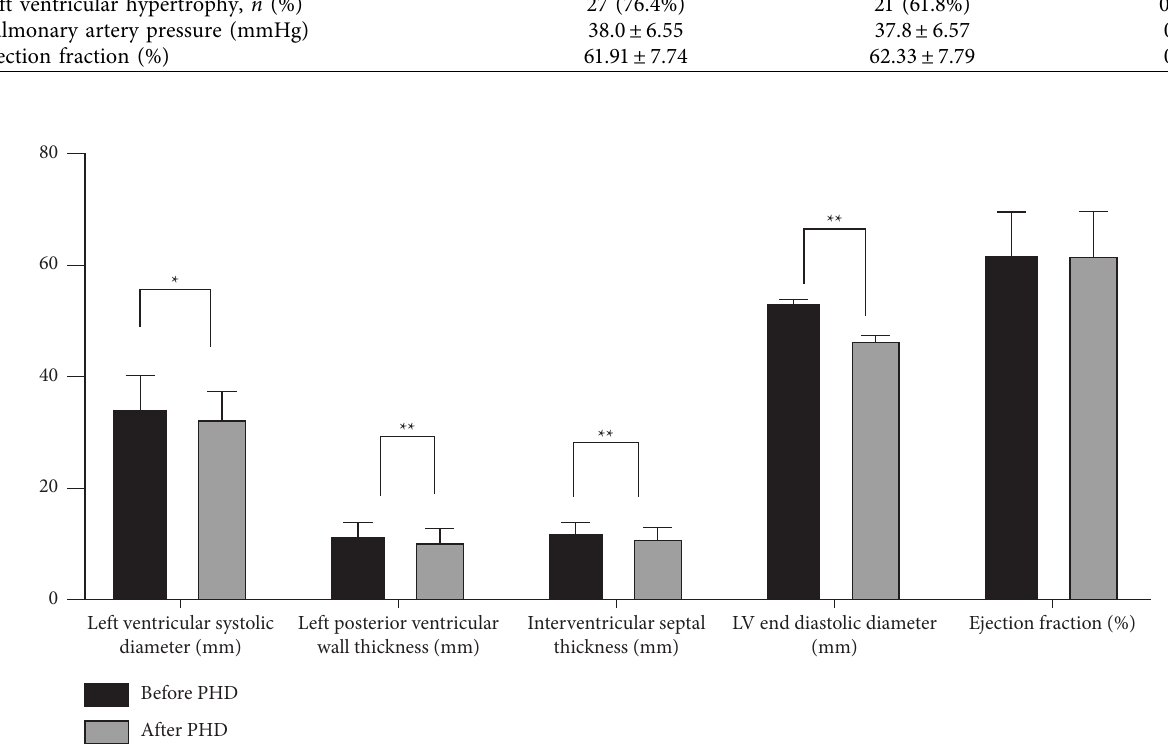
Figure 3: Comparison of echocardiographic results before and after PHD ( ∗ p < 0 . 05; ∗∗ p < 0 .